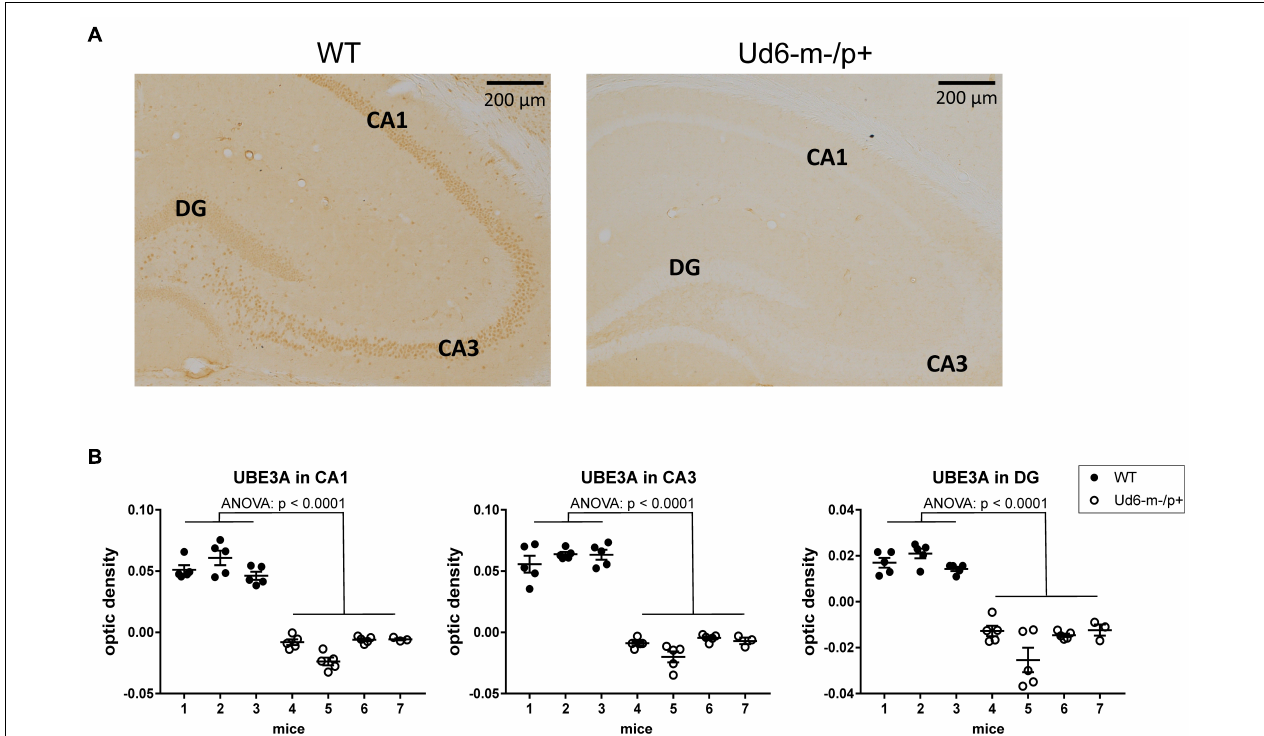
FIGURE 2 | Reduced abundance of UBE3A protein in the Ud6-m-/p+ hippocampus. (A) Representative images of immunohistochemical (IHC) detection of UBE3A in coronal brain sections through the hippocampal CA1-3 and dentate gyrus (DG) of wild type (WT; left) and Ud6-m-/p+ (Ud6; right) mice. UBE3A-immunopositive cells (brown dots) are absent in all hippocampal regions of Ud6-m-/p+ mice. Scale bar = 200 µ m. (B) Quantification of IHC results by optical density measurement in the subregions of the hippocampus. Data are expressed as individual values for each separate section ( n = 3–5 per brain) and as the group mean ± S.D., WT n = 3, Ud6-m-/p+ n = 4 (individual mice numbered along abscissa; numbers 1–3 for WT and 4–7 for Ud6-m-/p +). Error bars are SEM.